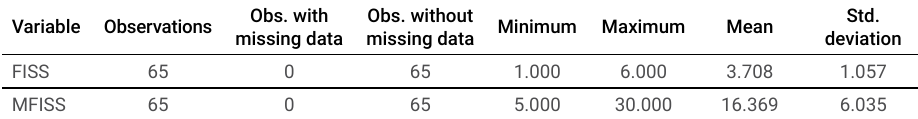
Table 1. FISS and MFISS scores statistical characteristic registered among study sample Variable Observations